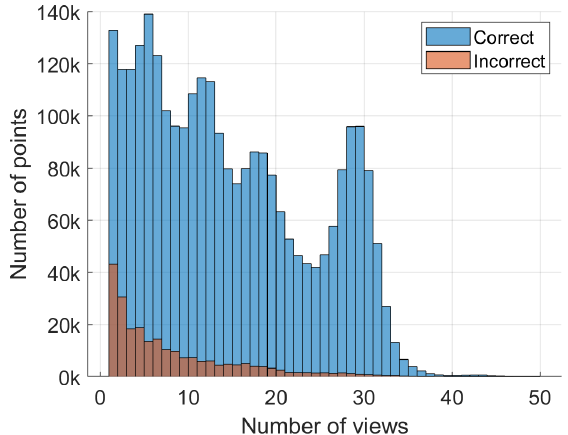
Figure 8. Counts of correctly and incorrectly classified points as functions of the number of views from which they are visible. on the 3D segmentation is evaluated varying the average per- centage of points incorrectly classified from 2% to 7%. The obtained 3D point classification results are shown in Table 3.